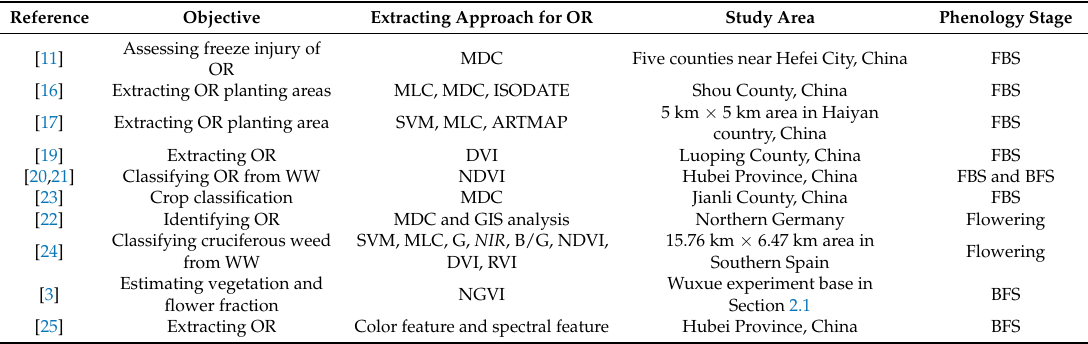
Table 6. Comparison of the existing OR extracting approaches using multispectral